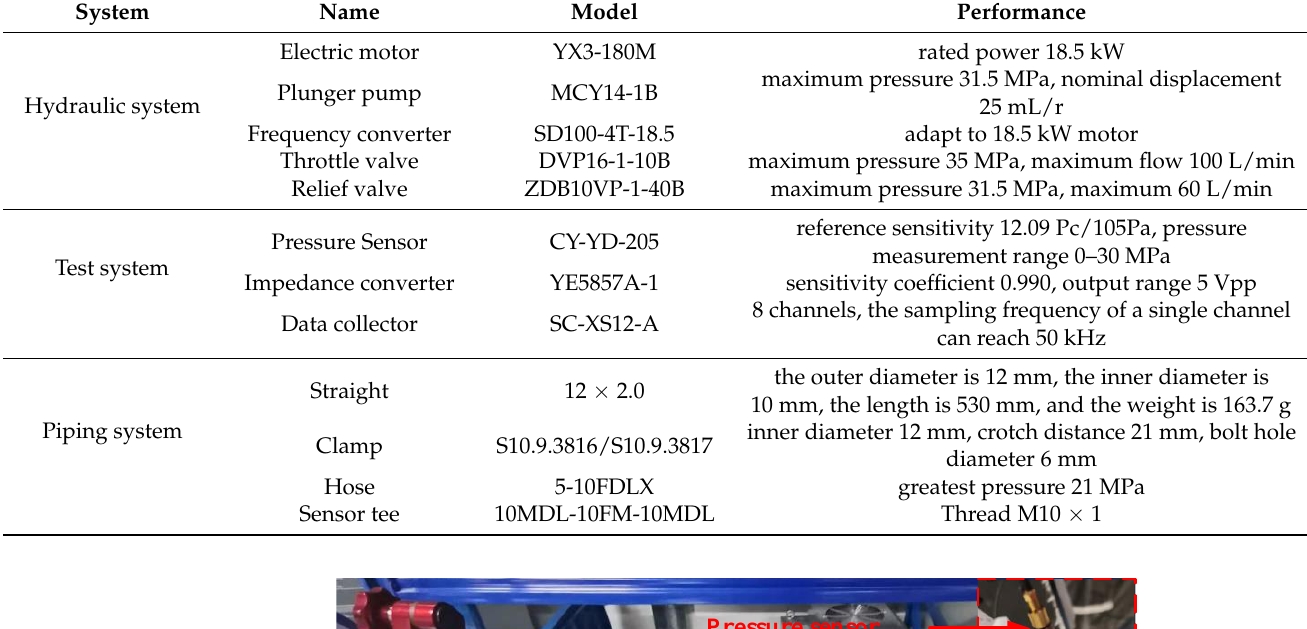
Table 4. Main components of the pump source fluid pressure fluctuation test platform.